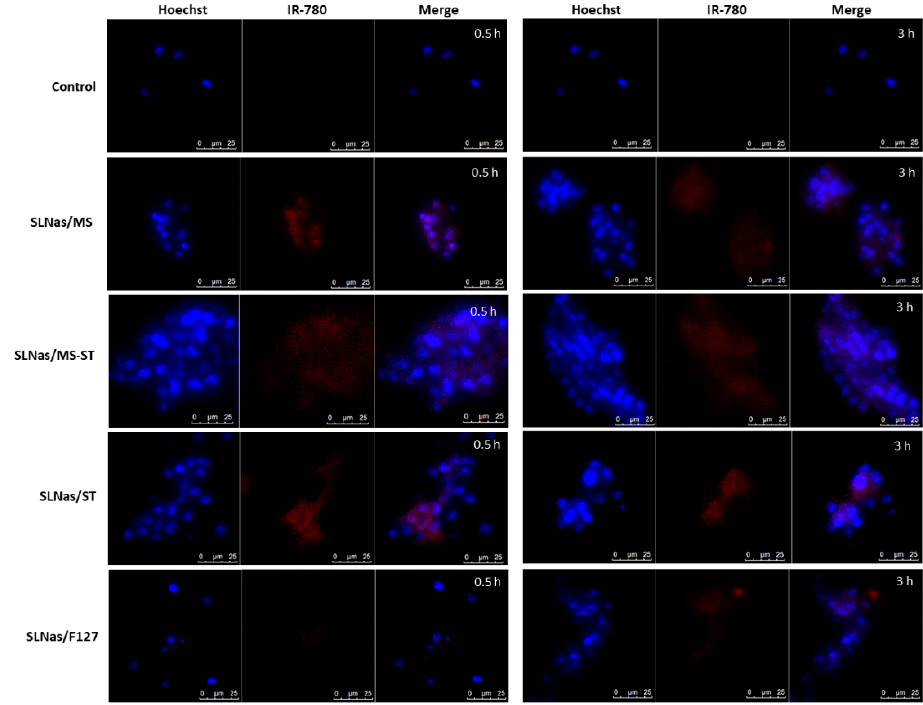
Figure 4. Fluorescence microscopy on AM from BALF showing SLNas post-exposure. Pictures were taken with a 40 × magnification. From left to right, first frame: image taken using the filter for Hoechst staining (cells); second frame: image taken using the filter for IR-780 (SLNas); third frame: merge, showing BALF AM in blue and IR-780 / SLNas in red. Animals were euthanized after 0.5 (right panel) and 3 h (left panel) post-exposure and BALF was immediately collected for analysis. Scale bars = 25 µ m.